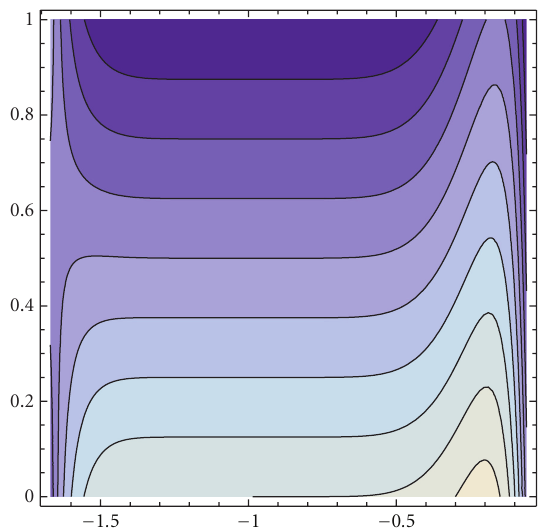
Figure 24: Contour plot of ( ∂ 3 /∂t 3 ) Y 10 (0, r ).